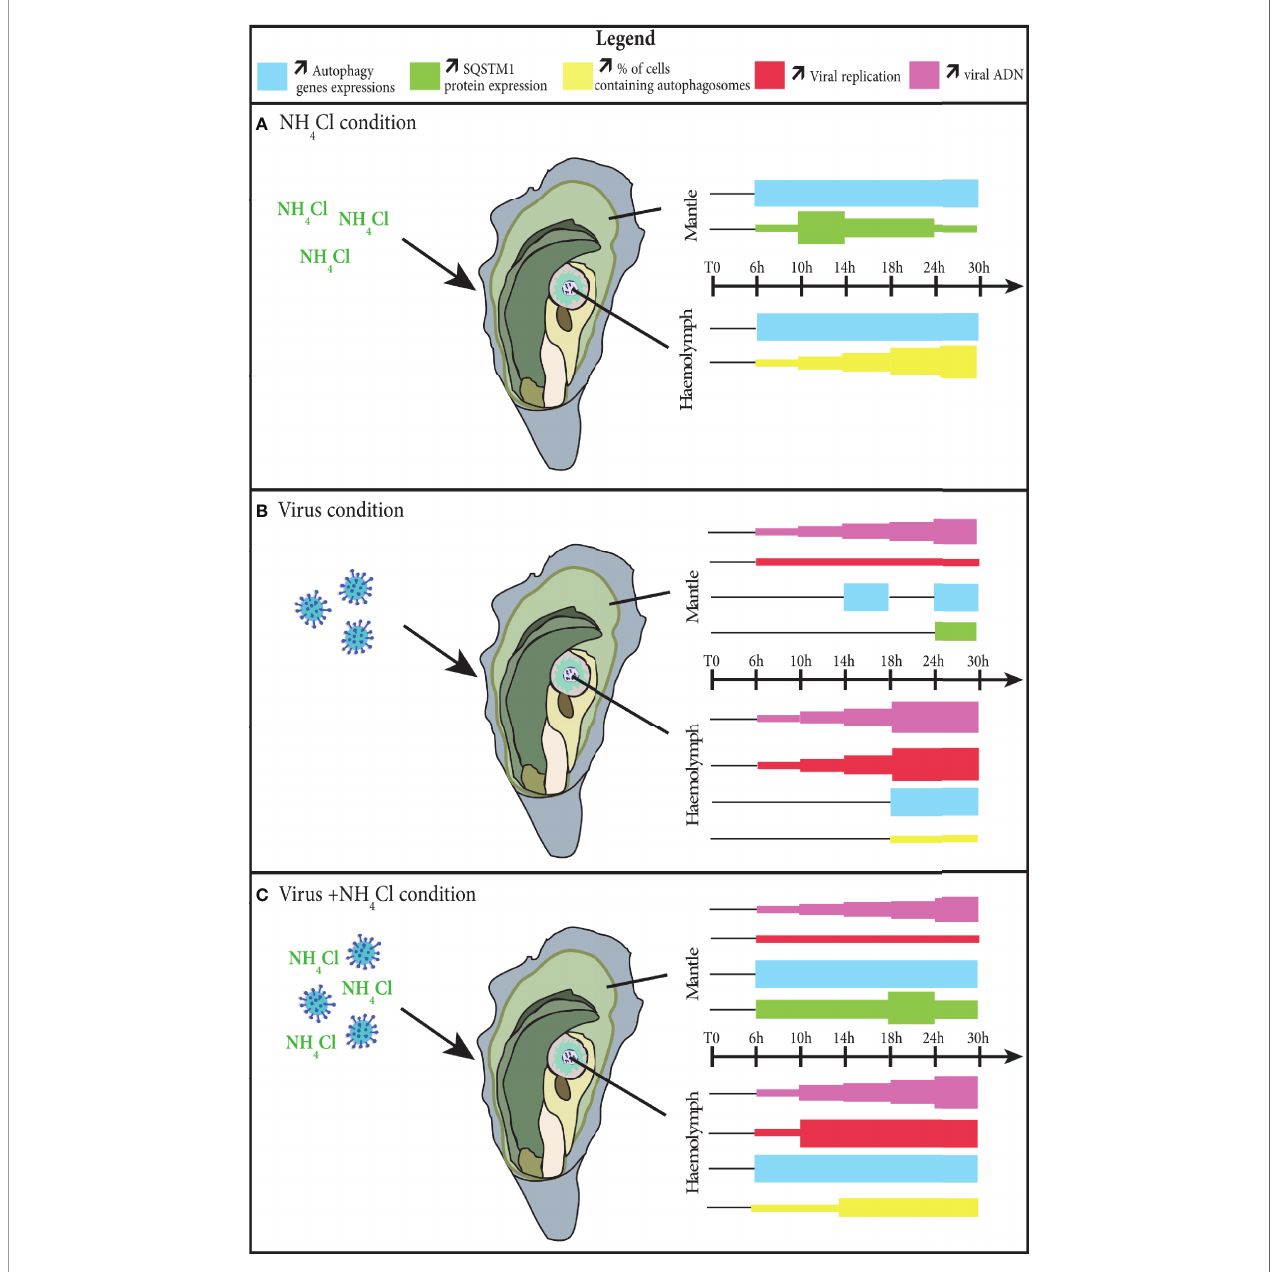
FIGURE 6 | Modulation of autophagy in the mantle and haemolymph of the Crassostrea gigas , during the process of an infection by the virus OsHV-1. (A) in the NH 4 Cl condition; (B) in the virus condition; (C) in the virus+NH 4 Cl condition. The thickness of each color square represents an increase of the parameter